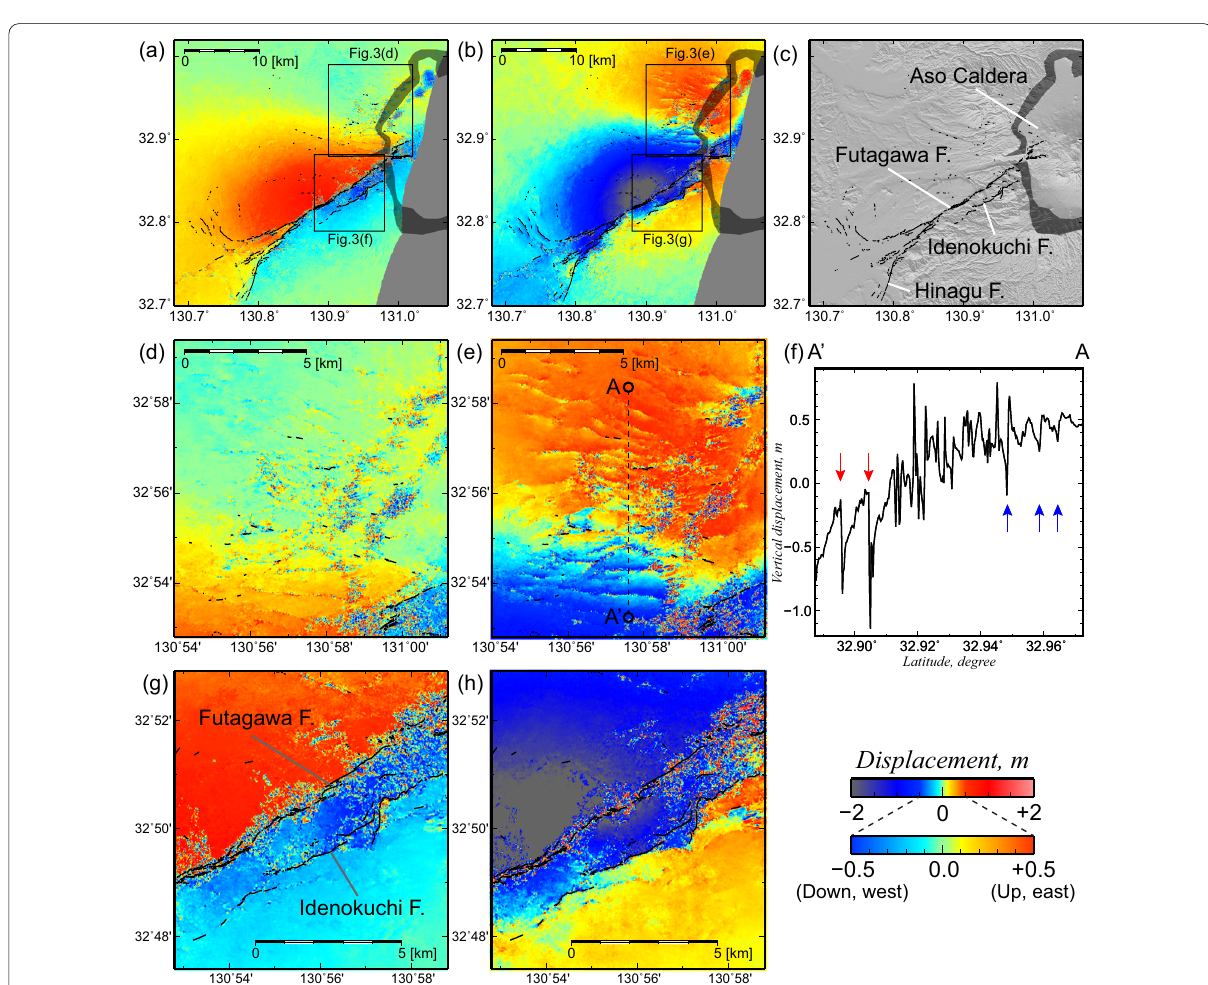
Fig. 3 Two-dimensional crustal deformation calculated from the slant-range changes for Paths 28 and 126. Thin lines depict the surface ruptures associated with the 2016 Kumamoto Earthquake (Awata et al. 2019; National Institute of Advanced Industrial Science and Technology 2019). a Quasi-east–west (QEW) component of crustal deformation. The quasi-east direction is rotated 3 degrees clockwise from the east. The two boxes correspond to the areas of ( d and g ), respectively. Shaded areas show the caldera wall. b Quasi-up–down (QUD) component of crustal deformation. The quasi-up direction inclines 8 degrees northward from the vertical. The two boxes correspond to the areas in ( e and h ), respectively. c Topographic relief map. ( d , e ) Distribution of the QEW and QUD components, respectively, enlarged west of the Aso Caldera, corresponding to Fig. 1c. f Vertical displacement along the profile A–A’ shown in ( e ). ( g , h ) Distribution of the QEW and QUD components, respectively, enlarged around the Futagawa Fault, corresponding to Fig.